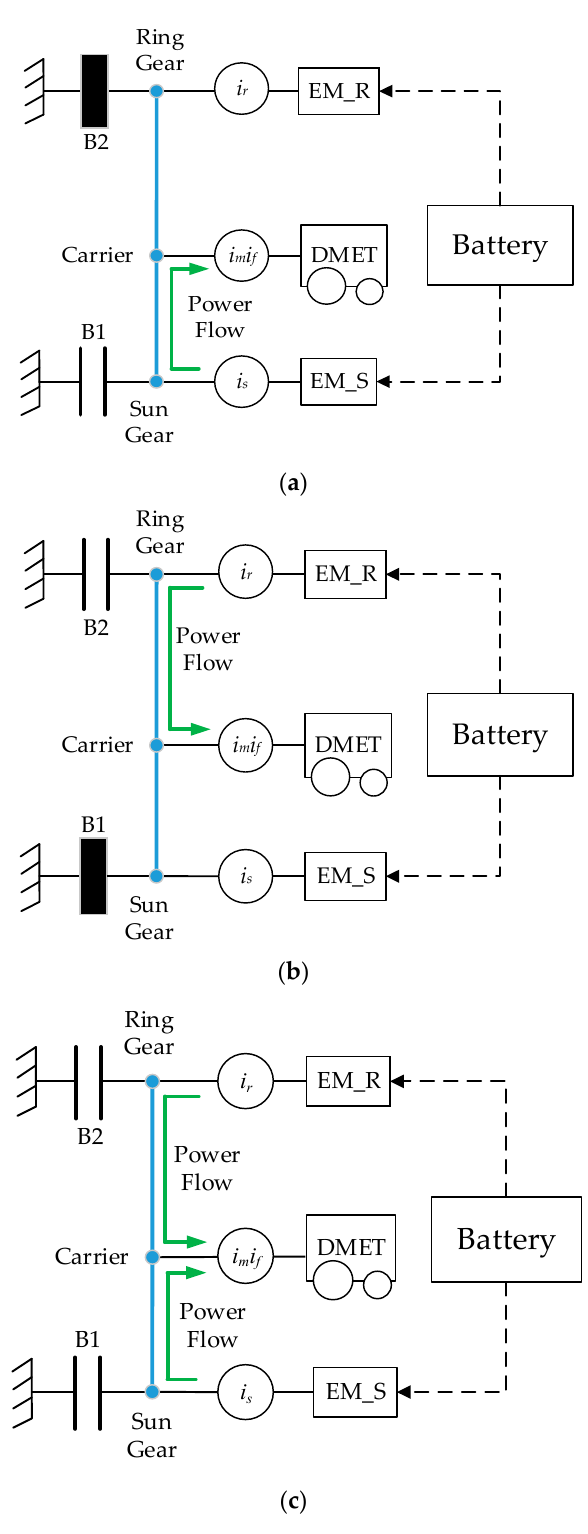
Figure 2. ( a ) Power flow in M1S mode. ( b ) Power flow in M2S mode. ( c ) Power flow in DMC